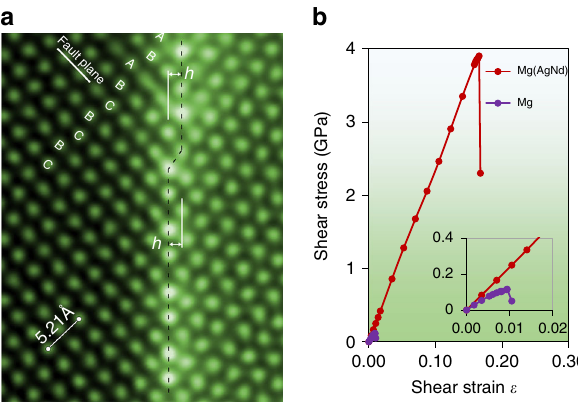
Fig. 5 Effect of co-segregated solutes on twin boundary migration mechanism and pinning. a HAADF-STEM image of a 10 (cid:1) 12 ð Þ twin interface containing a step of a single layer height. b Calculated shear stress-strain plot for the migration of a 10 (cid:1) 12 ð Þ twin interface. The red line gives the shear stress when the expansion site on the twin fi lled with Nd and the compression site fi lled with Ag and the purple line is when both expansion and compression sites are fi lled with In fl uence on twin boundary mobility . The co-segregation of Nd and Ag atoms to twin boundary is expected to signi fi cantly reduce the twin boundary mobility. Thermodynamically, the solute segregation will reduce boundary energy and hence increase the stability and simultaneously reduce the mobility of the twin boundary. Kinetically, the solute segregation in the twin boundary will exert a pinning or drag effect on the boundary migration. The segregation of solutes to grain boundaries has been reported to generate a signi fi cant drag effect on grain boundary migration, which retards the grain growth 12,34,35 . The effect of the solute co- segregation on twin boundary mobility was examined by fi rst- principles computation. A calculated shear stress versus strain (cid:1) curve for a 10 12 ð Þ twin boundary, with and without segregated Nd and Ag atoms, is shown in Fig. 5b. In the situation where there is no solute segregation, i.e. pure Mg, the twin boundary starts to migrate when the applied shear stress is above 116 MPa. Signi fi cant improvements in shear stress, by 33 times, and elastic strain limit occurs when the twin boundary is populated with Nd and Ag. To understand this exceptional effect of the co-segrega- tion, a series of electron charge density plots are given in Sup- plementary Fig. 2. The increased charge density between Ag and Nd with the Mg indicates a stronger bond and a strengthening of the twin. As the shear deformation is applied, the Mg is pushed towards the Nd and away from the Ag.